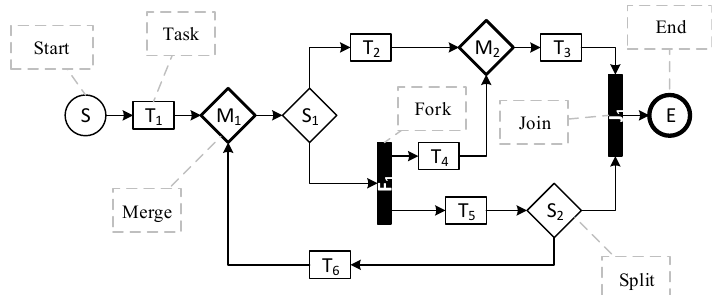
Figure 4. A workflow graph with its different node visualizations